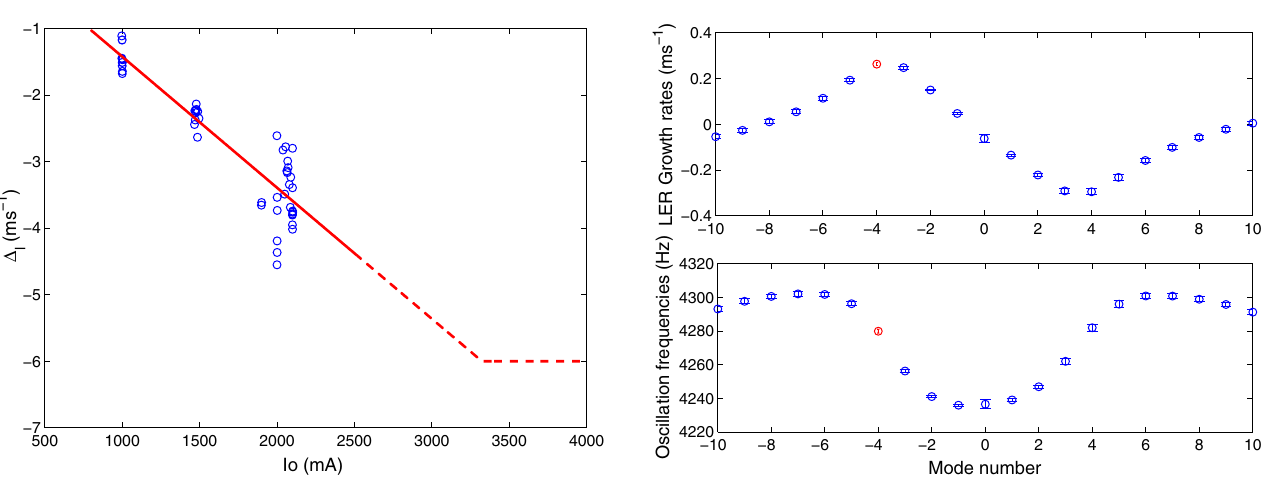
FIG. 7. (Color) Plot of (cid:3) with current in mA. The (cid:1) 6 ms (cid:1) 1 l limit is from the low-mode longitudinal control